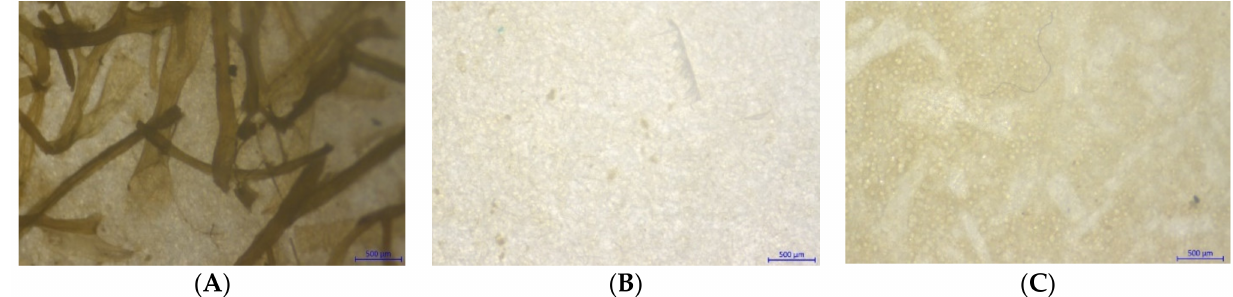
Figure 5. Dried G. fisheri and suspected MPs after enzymatic digestion 1% ( v / v ) cellulase and 5% ( v / v ) protease ( A ), oxidative digestion using sample to 30% H 2 O 2 ratio of 1:100 ( B ), and combination digestion using 1% ( v / v ) cellulase and 5% ( v / v ) protease and oxidative ratio of 1:100 ( C ). Specimens were viewed at 10 × objective. Rectangular sign points at suspected MPs.